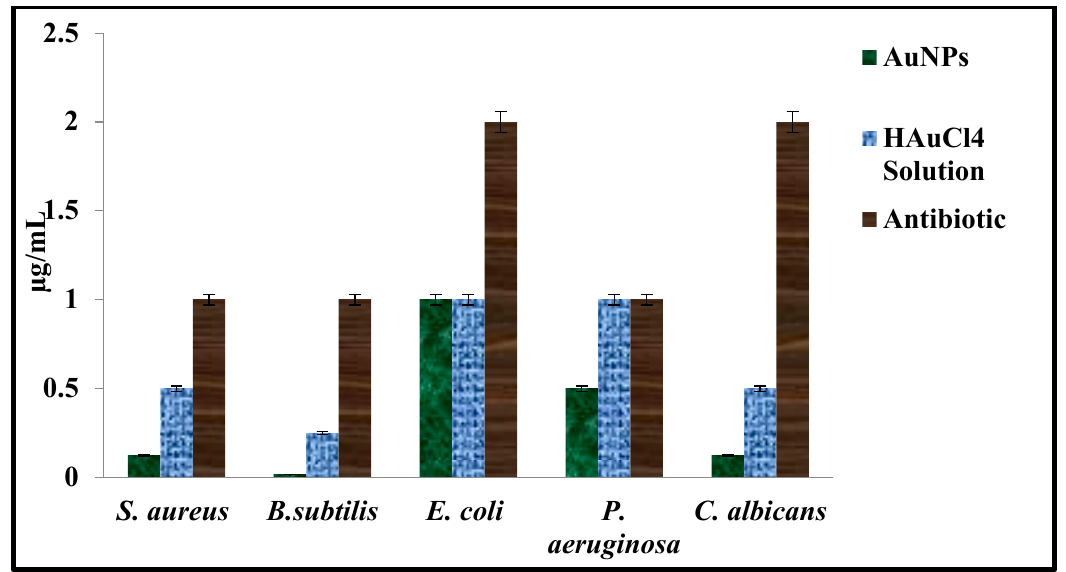
Figure 11. MIC concentrations of synthesized AC-AuNPs, HAuCI 4 solution, and antibiotics (vanco- mycin, colistin, and fluconazole). Table 4. The concentrations of AuNPs that were effective in suppressing the growth of microorgan- isms in different biologically sourced green synthesis studies.